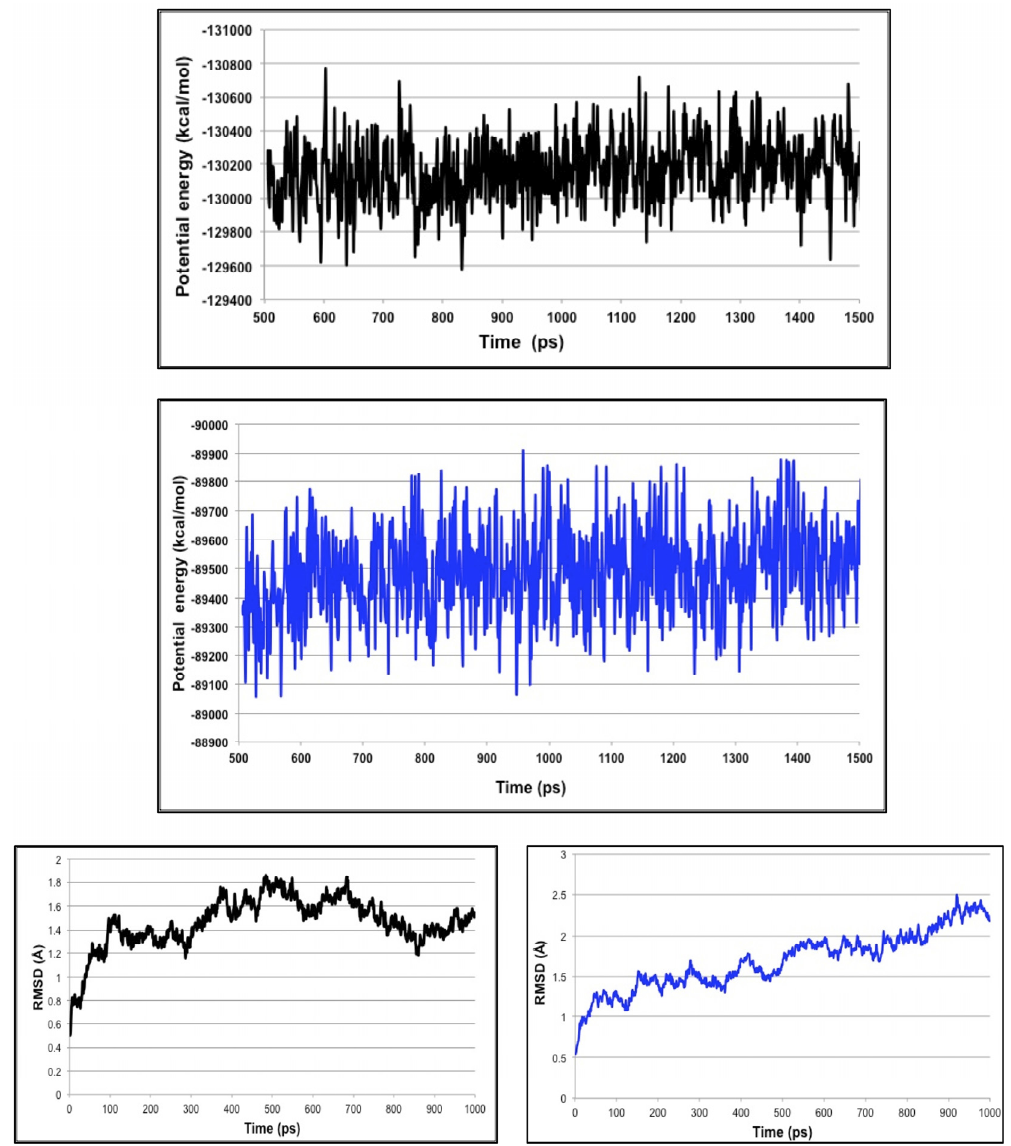
Figure 9. The highest ranked virtual screening hit lead complexes with CCR5 subjected to MD simulations. Structure-based compound (ZINC71849459) in complex with CCR5 (Black). Pharmacophore-based compound (ZINC00634884) with CCR5